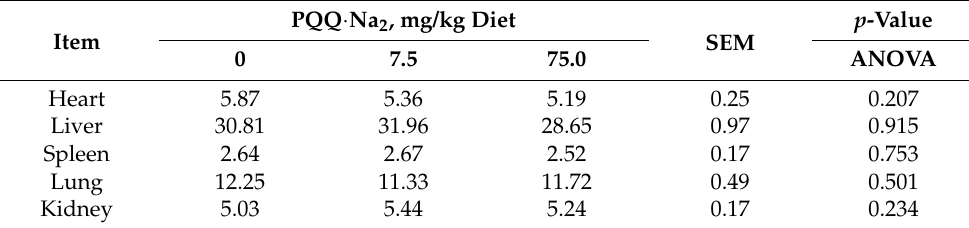
Table 6. Effects of graded levels of PQQ · Na 21 on organ index of weaned piglets (g/kg BW) 2.